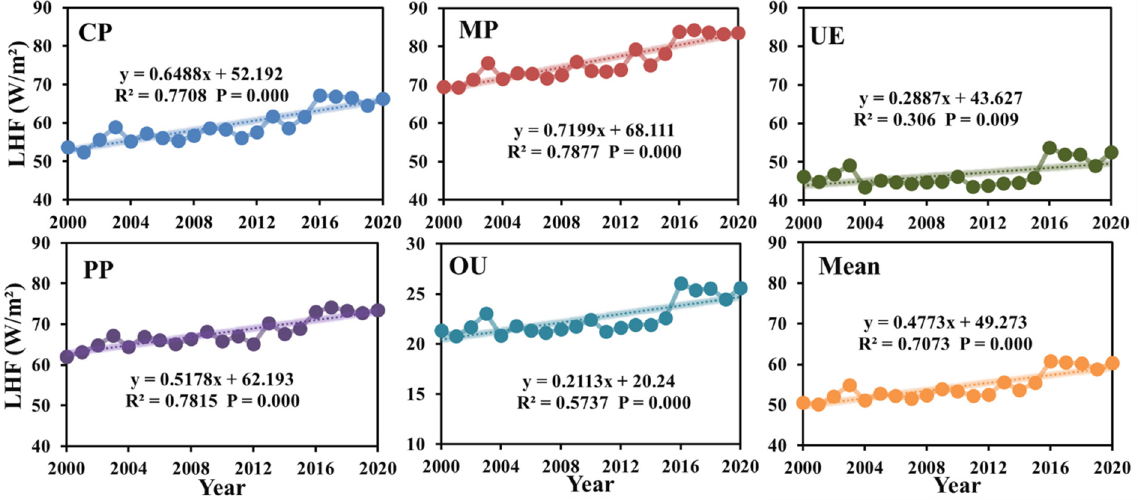
Figure 9. Latent heat flux (LHF) trend of different land use types in the Yangtze River basin from 2000 to 2020.